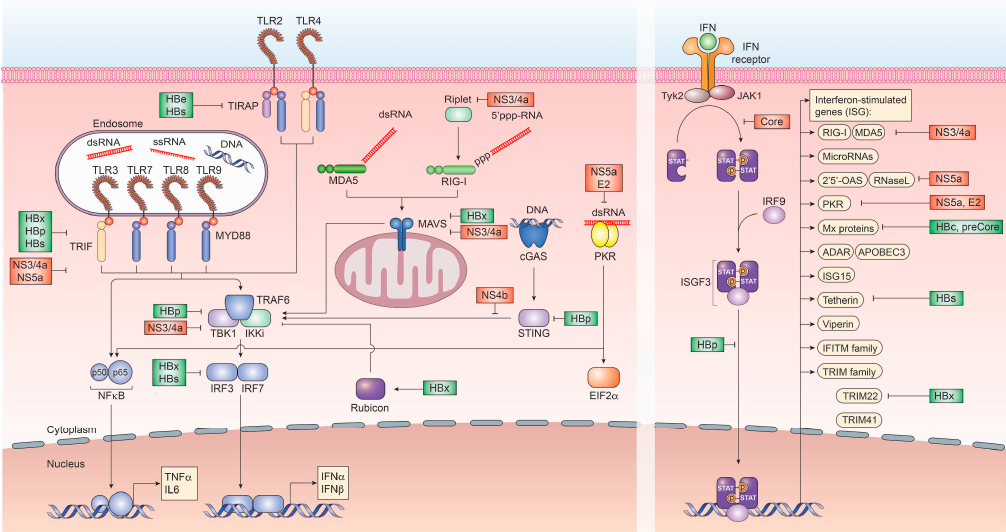
Figure 1. Recognition of hepatitis B virus (HBV) and hepatitis C virus (HCV) by pattern-recognition receptors and immune evasion strategies. Innate immune signaling pathways involved in the recognition of HBV and HCV infection and the subsequent induction of interferon and interferon-stimulated genes. Several viral proteins of HCV (red) and HBV (green) interfere at various stages with these pathways.